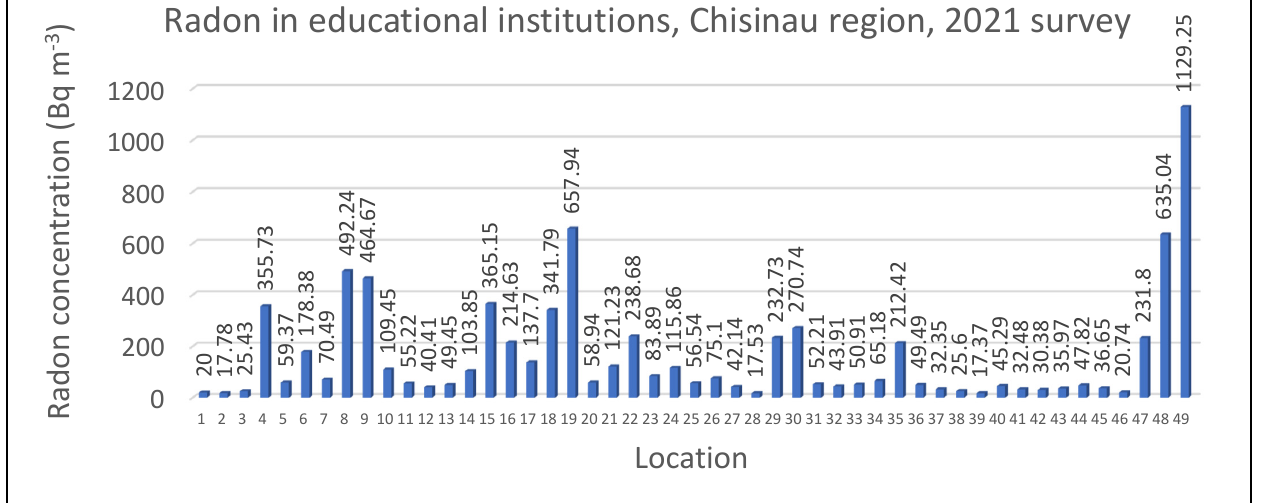
Figure 3. Distribution of radon concentrations in educational institutions in the Republic of Moldova, Chisinau region, during the 2021 survey.